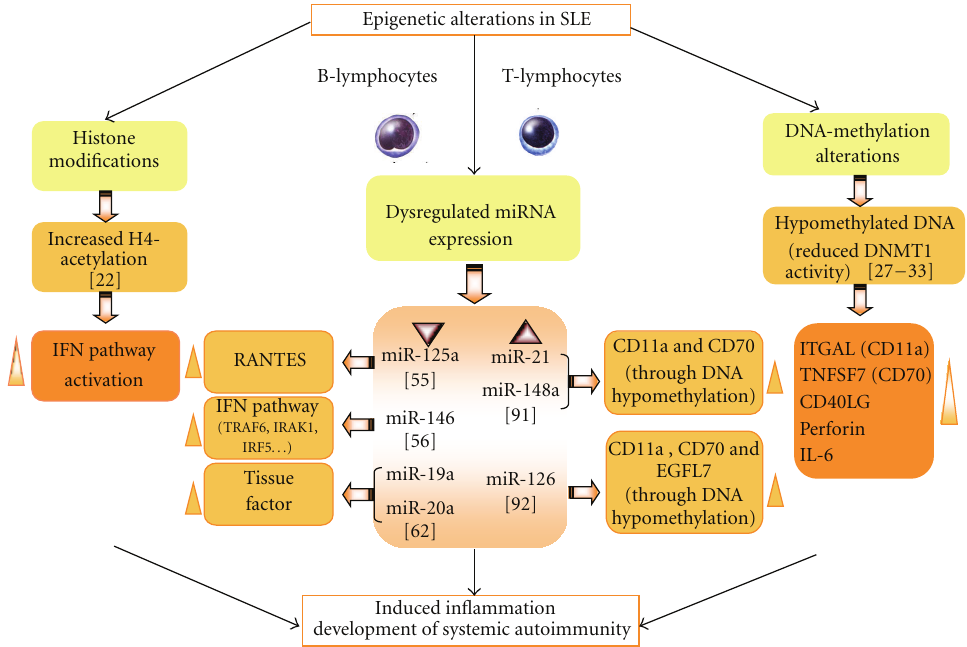
Figure 1: Epigenetics alterations in SLE and potential pathogenic contributions to inflammation, CVD, and autoimmunity. See the text for further details.